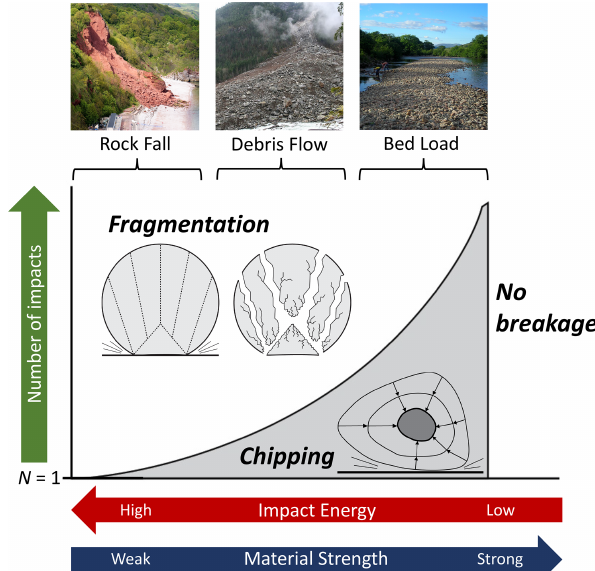
Figure 1. Schematic phase diagram delineating attrition mecha- nism as a function of impact energy (influenced by collision veloc- ity and particle mass) or material strength, and number of impacts; adapted from the proposed diagram of Zhang and Ghadiri (2002). For extremely weak materials or high-impact energies (left), explo- sive fragmentation can occur from a single collision. As material strength increases or impact energy decreases (center), fragmen- tation occurs through fatigue failure, where cracks grow progres- sively through the material with each collision. In the limit of pure chipping, which applies to low-impact energies or strong materials (right), the number of impacts required to produce fragmentation increases toward infinity. Examples of transport mechanisms asso- ciated with fragmentation, fatigue failure, and pure chipping are rockfalls, debris flows, and bed-load transport, respectively. Frag- mentation figure is adapted from Salman et al. (2004b); chipping figure is adapted from Szabó et al. (2013); photographs of transport mechanisms are reproduced from Wikimedia Commons.